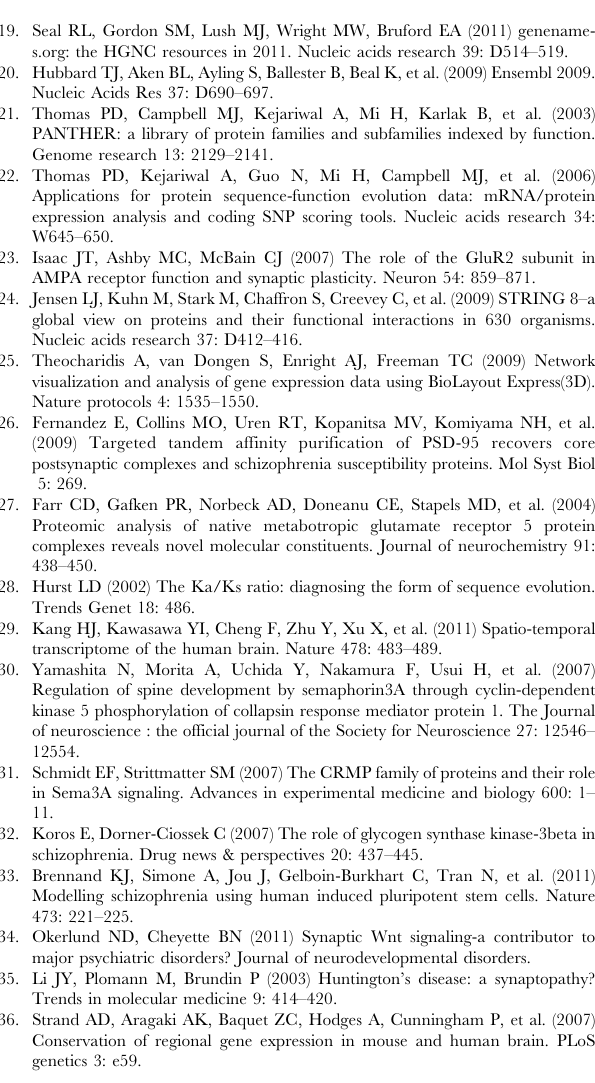
Table S8 Functional Comparison of all PSD Proteins Identified in Human and Mouse. All human and mouse PSD proteins were classified together using the Panther ‘Protein Class’ descriptor. An enrichment analysis was done to determine Protein Classes overrepresented compared with the human genome. The Benjamini-Hochberg procedure was used to correct for multiple testing. The column ‘observed’ retrieves the number of proteins identified in each ‘Protein Class’ while the column ‘expected’, the number that would have been identified by chance. Over or under-representations are shown by a ( + ) or ( 2 ) symbol respectively. Table S9 Pathway analysis of all PSD Proteins Identified in Human and Mouse. All human and mouse PSD proteins were